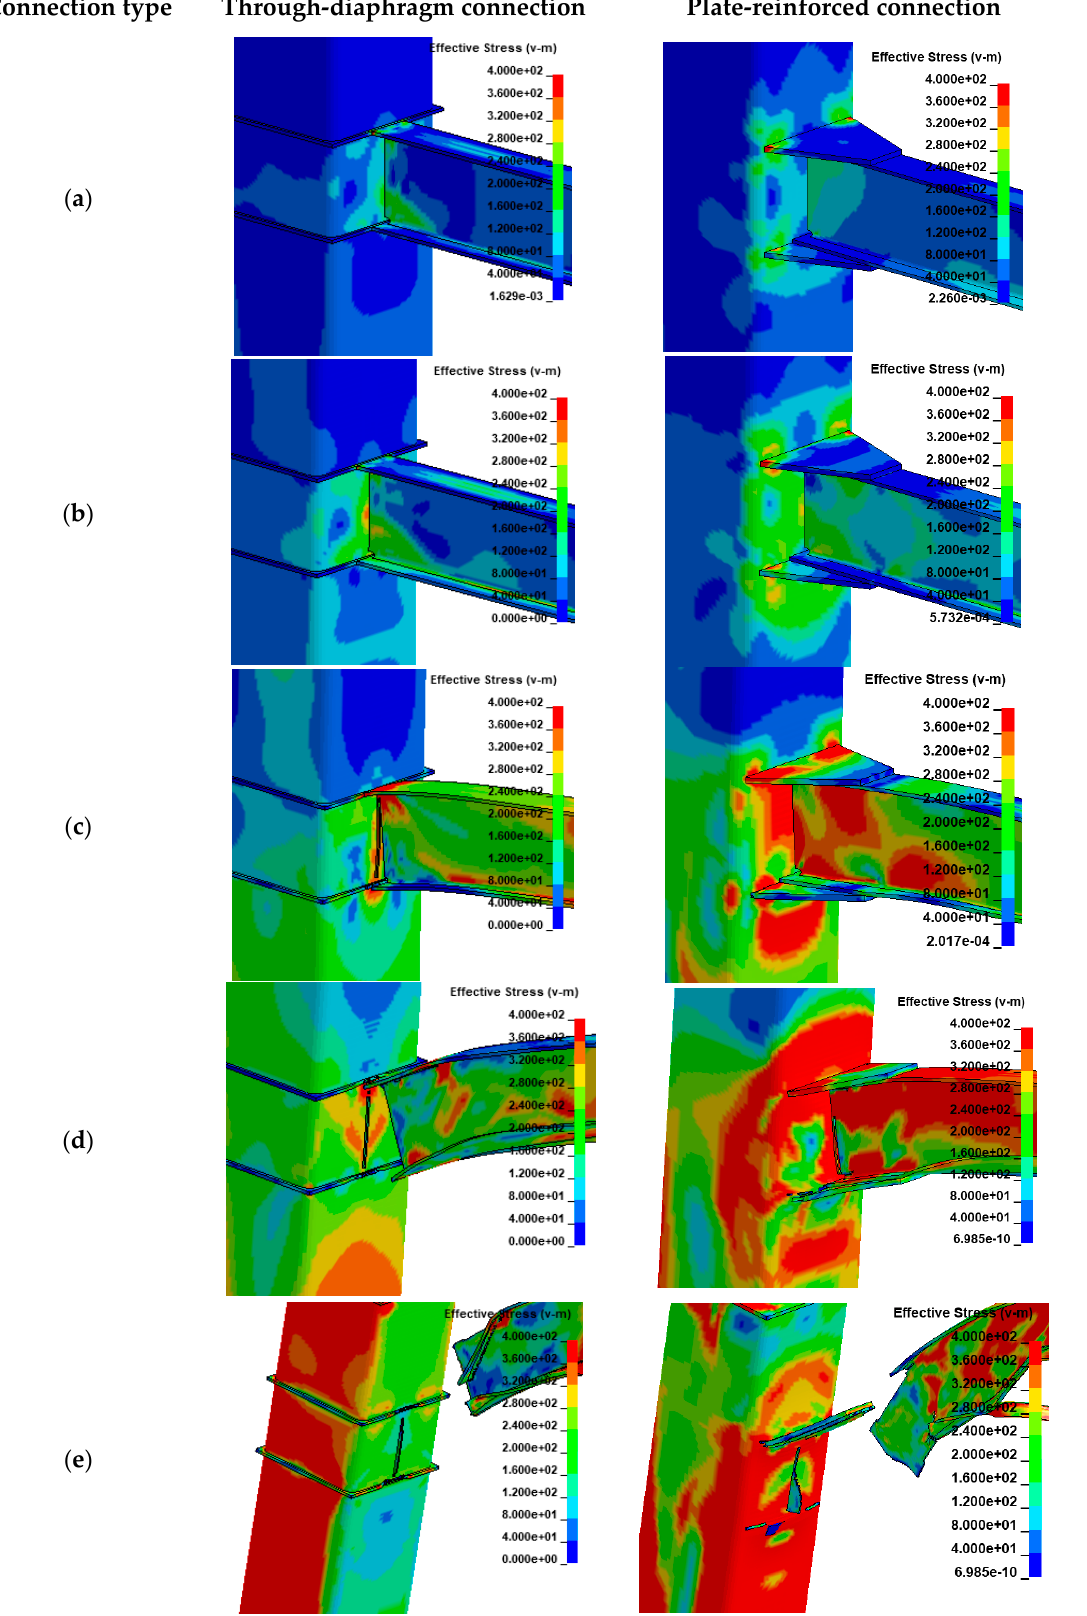
Figure 13. Von Mises stress distribution in the vicinity of connection of numerical models at t = 20 ms.